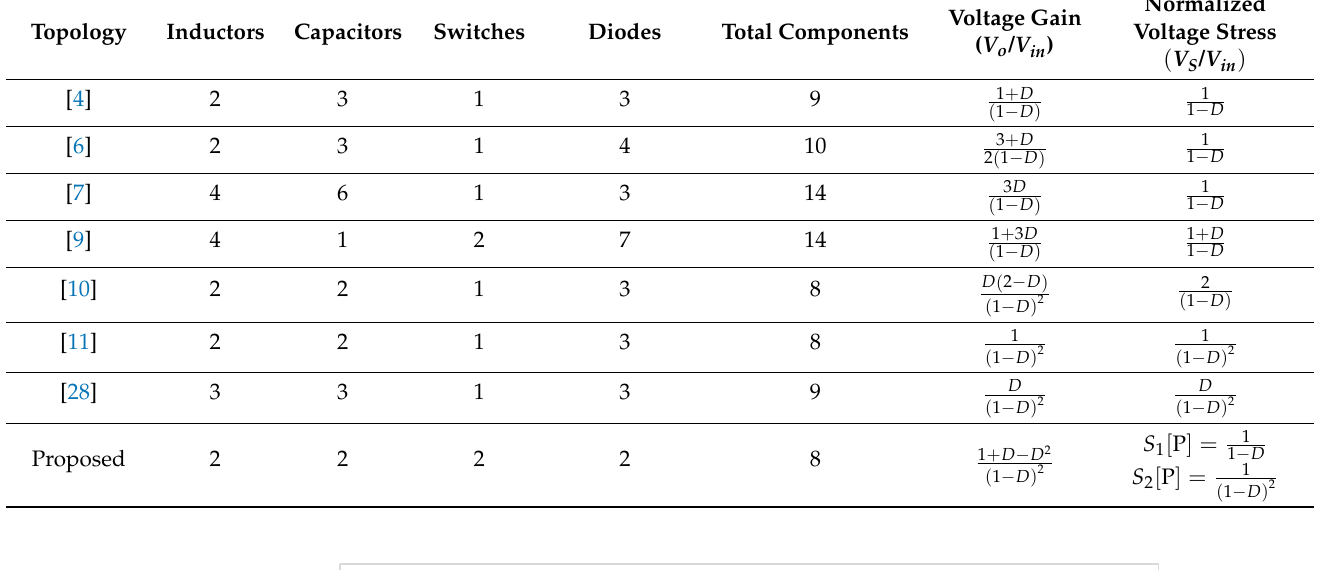
Table 1. Comparison of the proposed converter with similar topologies.